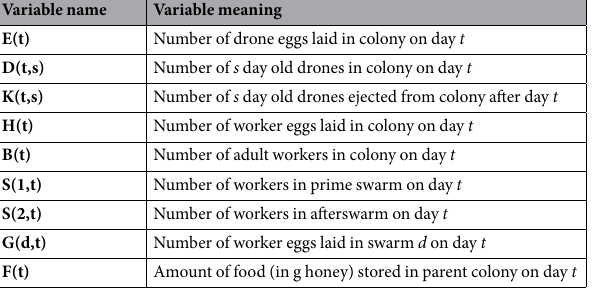
Table 1. Full list of model